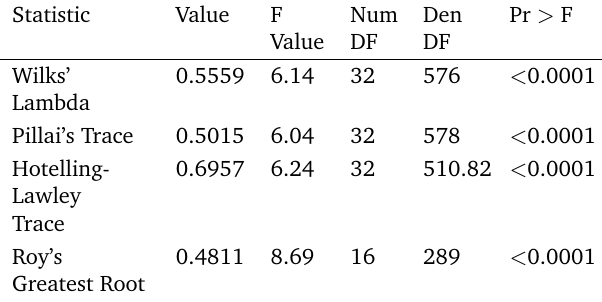
Table 9. Number and percent of observations classified into agro-ecological zones.